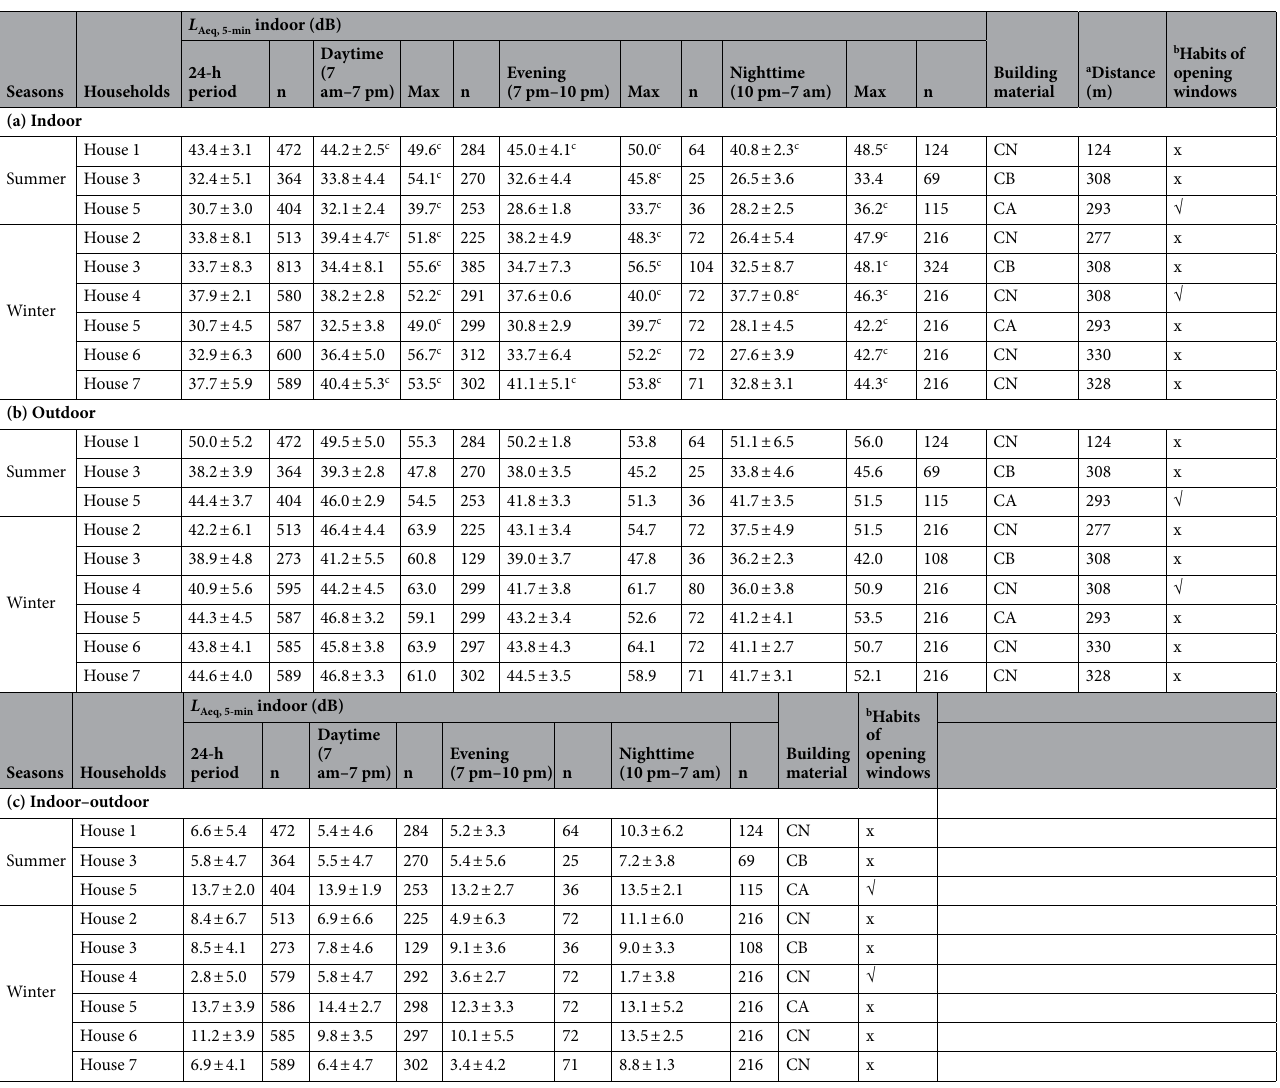
Table 3. L Aeq, 5-min LFN (dB, L Aeq ) measured at different households (a) indoors, (b) outdoors, and (c) outdoors minus indoors. CN concrete, CB concrete + brick, CA concrete + airtight windows. a Distance from the nearest wind turbine (m). b Habits of opening windows: √: fully open; x: slightly open or fully closed. c LFN exposure levels exceeding the respective standards designated by the Taiwan